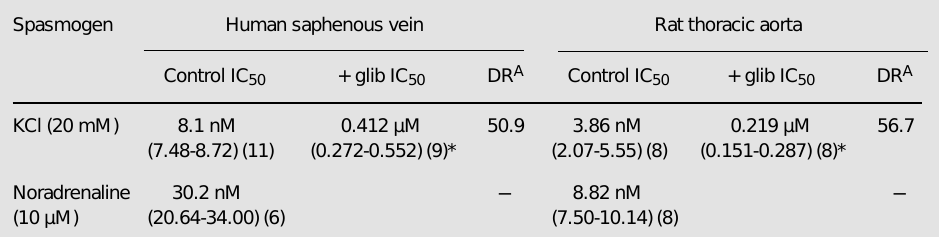
Table 1 - IC 50 values for SR 47063-induced relaxation of human saphenous vein and rat aorta. Values are reported as means, with 95% confidence limits and number of observations in